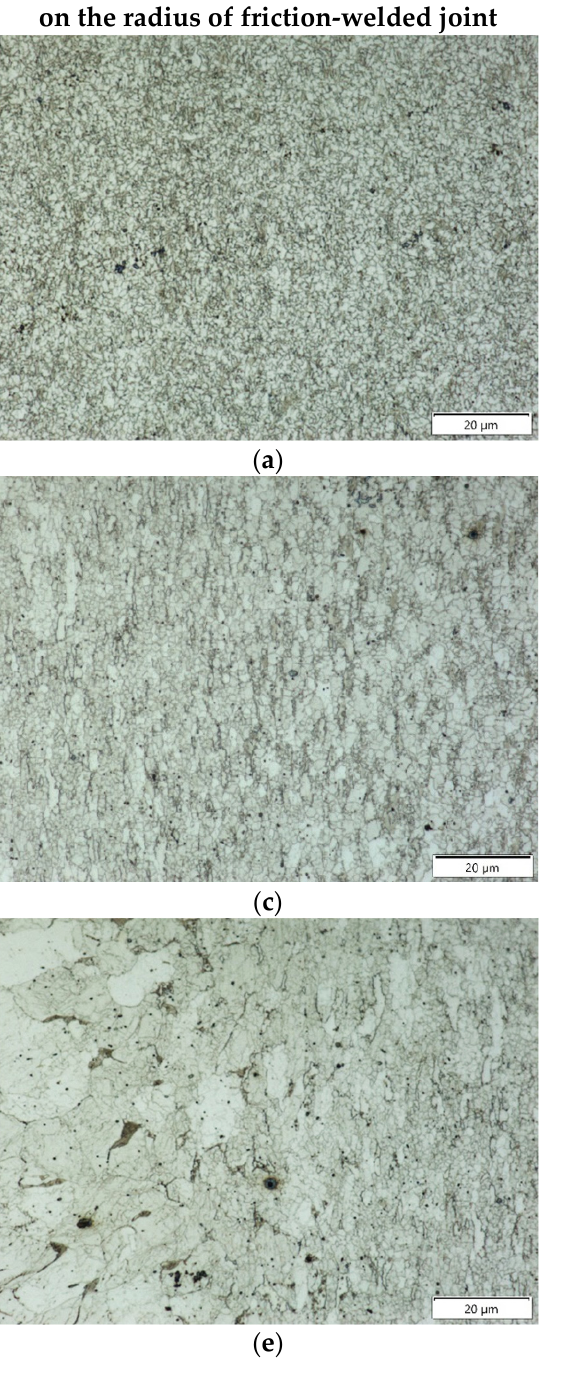
Figure 5. Microstructure of a friction-welded joint with p f = 191 MPa: ( a , b ) in friction weld, ( c , d ) in HAZ, ( e , f ) in transition zone between HAZ and BM.